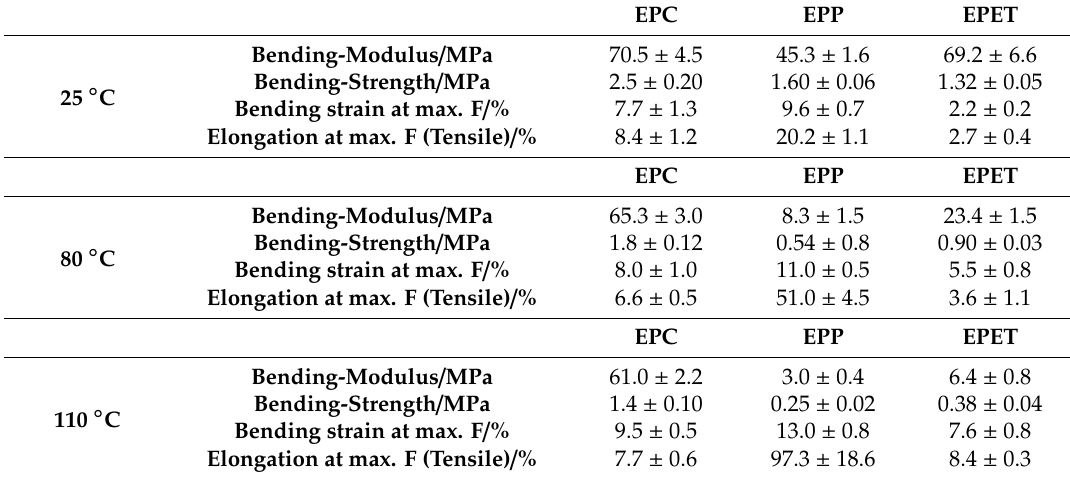
Table 4. Summary of bending characteristic-values of EPC, EPP, and EPET at 25, 80, and 110 ◦